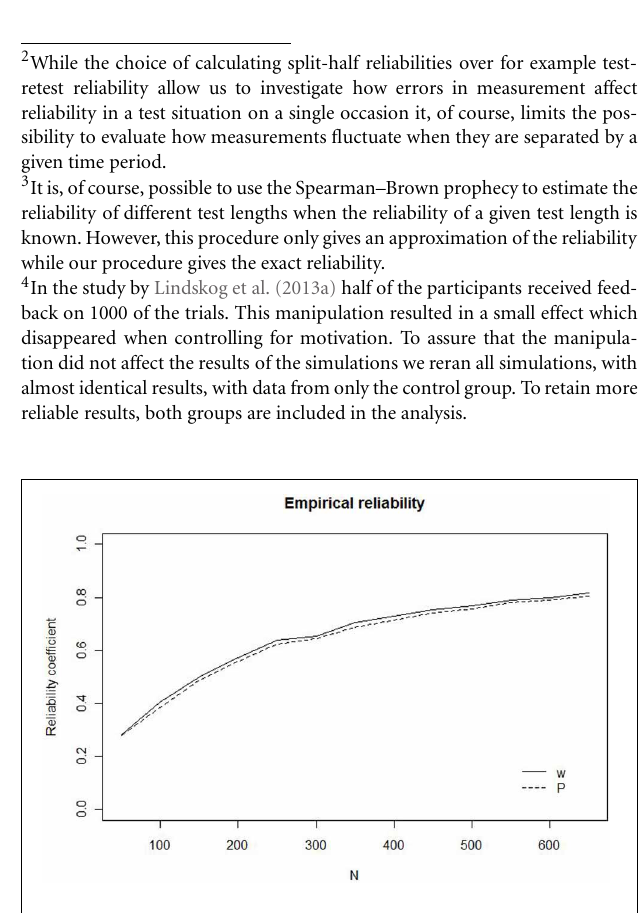
FIGURE 1 | Empirical reliability for w (solid line) and P (dashed line) as a function of the number of trials ( N